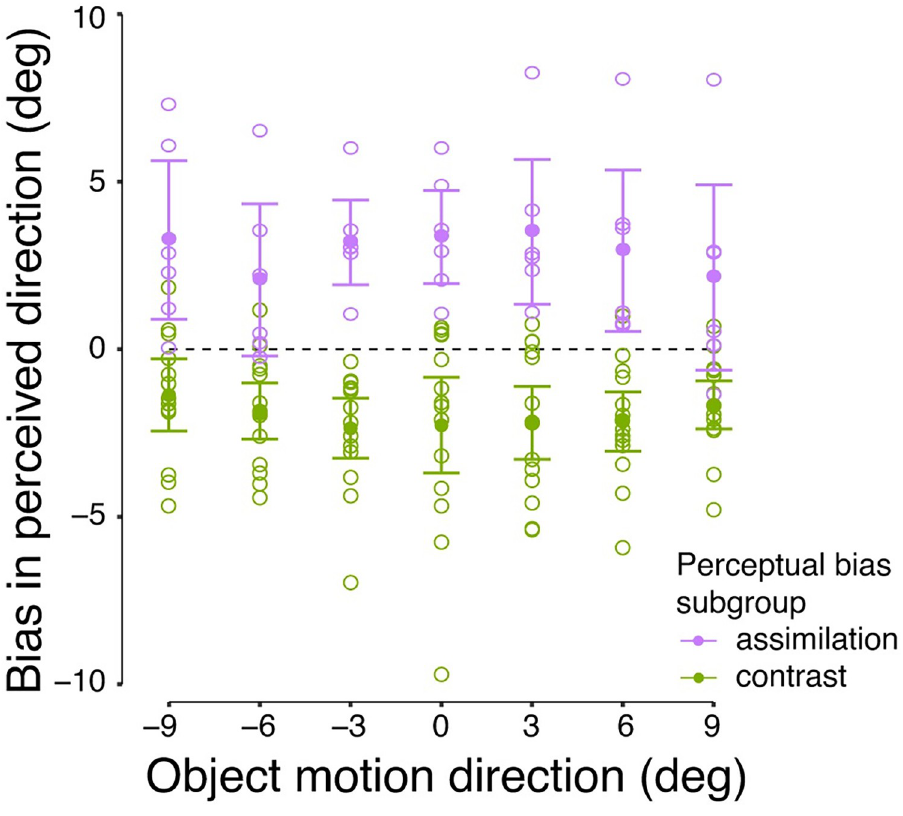
Fig 8. Perceptual bias patterns in all observers. Open symbols indicate the individual bootstrapped mean of perceptual bias in one object motion condition. Filled symbols indicate the average perceptual bias within each subgroup. Error bars indicate the 95%